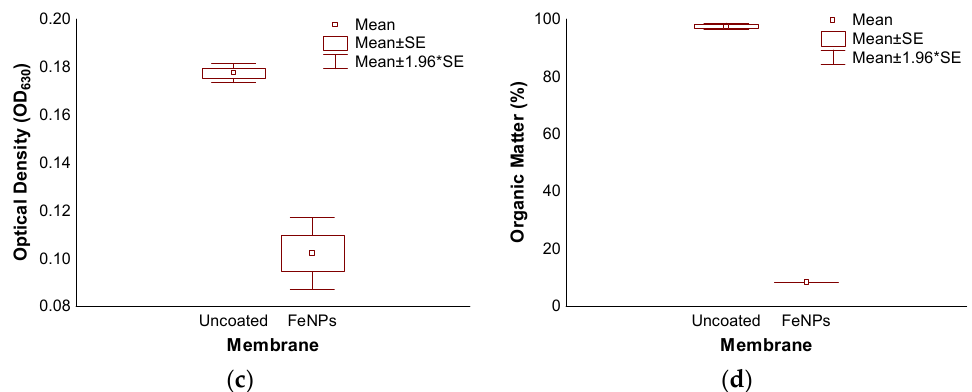
Figure 9. Effect of FeNP coating on biofilm parameters obtained after biofouling of RO membranes by Bacillus halotolerans MCC1: ( a ) thickness of biofilm layer formed onto the membranes; ( b ) bacterial count obtained from scraped biofilm; ( c ) optical density of scraped biofilm; ( d ) organic matter in scraped biofilm.